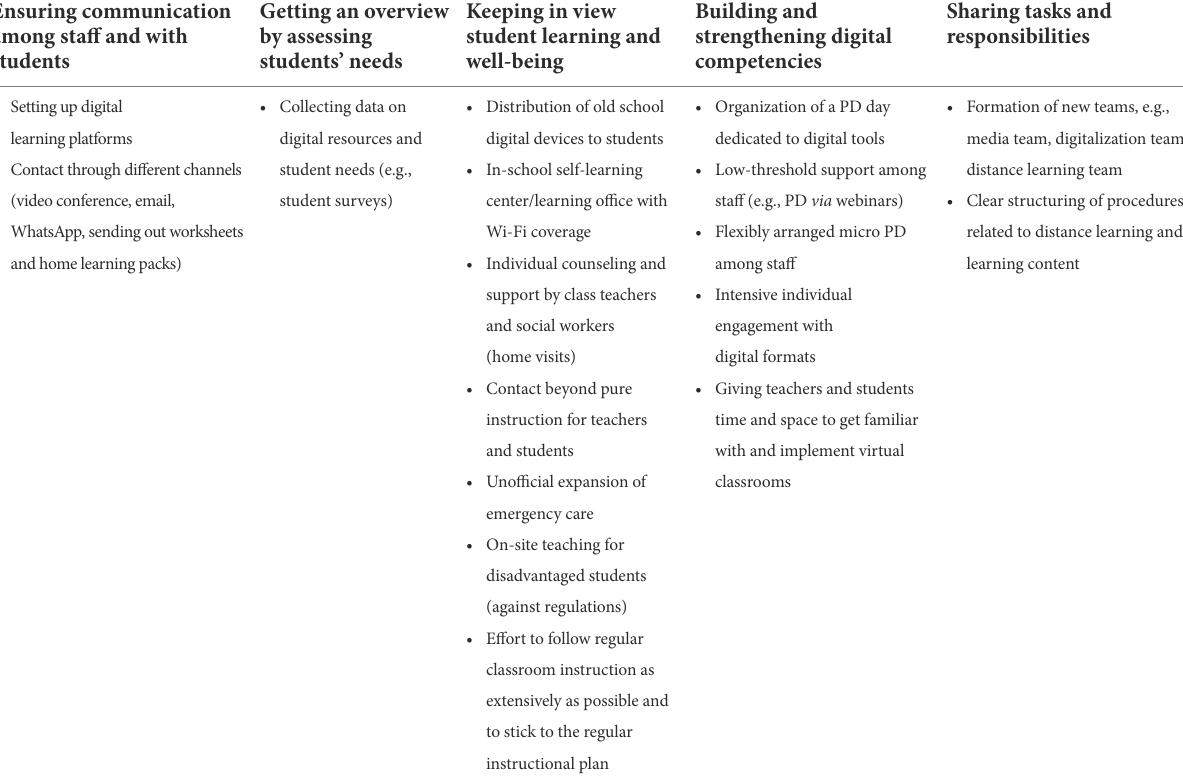
TABLE 4 Overview of the thematic fields from the qualitative interviews with school leaders. Ensuring communication among staff and with